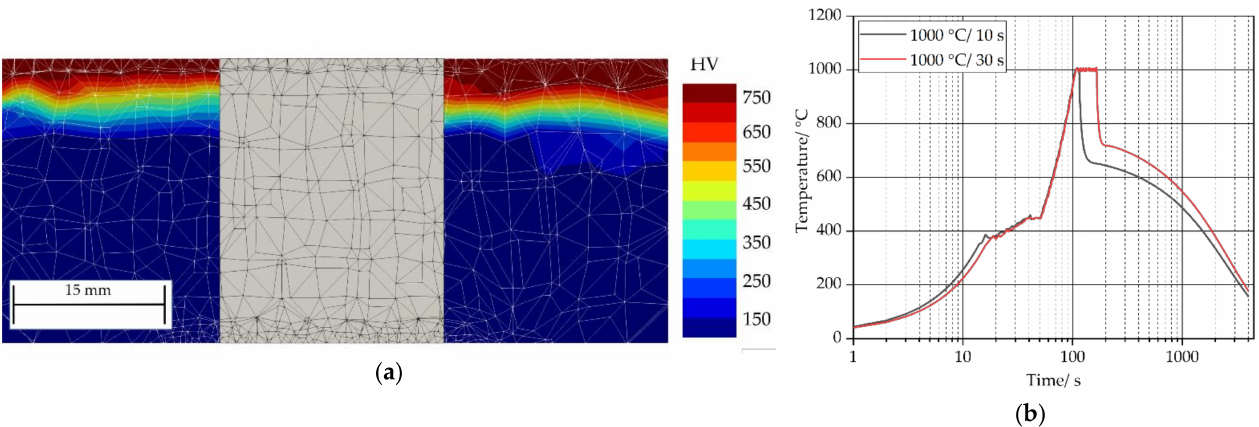
Figure 11. Comparison of a calculated hardness distribution within a cross-section after cooling down, left parameter combination 1000 ◦ C, 10 s and right 1000 ◦ C, 30 s (middle shows the mesh size) ( a ) and the corresponding simulated cooling curves ( b